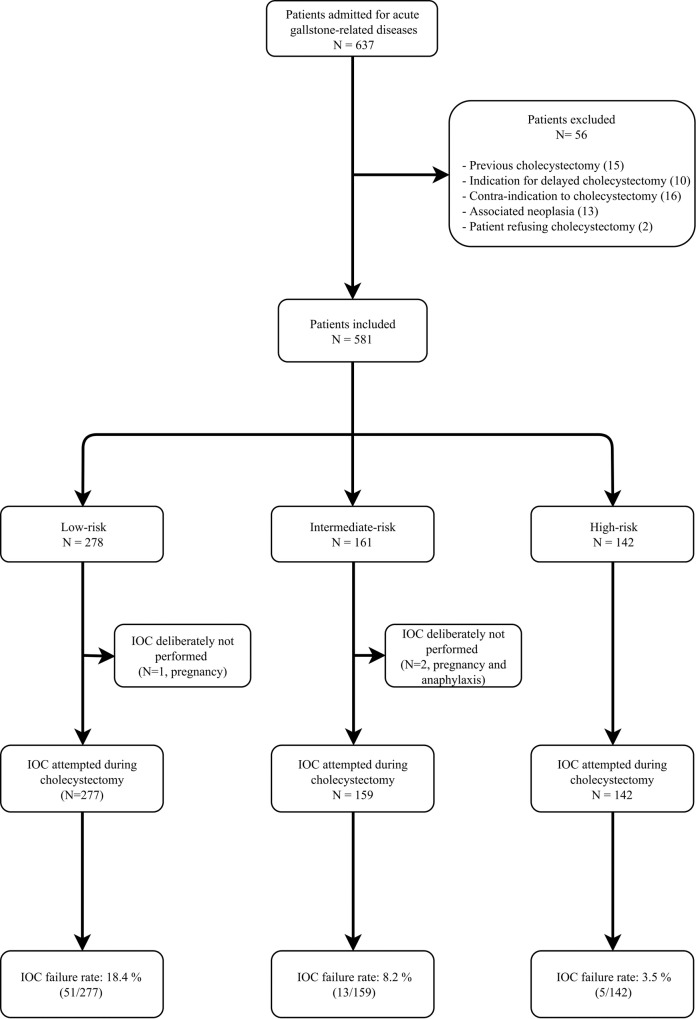
Flow-chart.IOC = intraoperative cholangiogram.